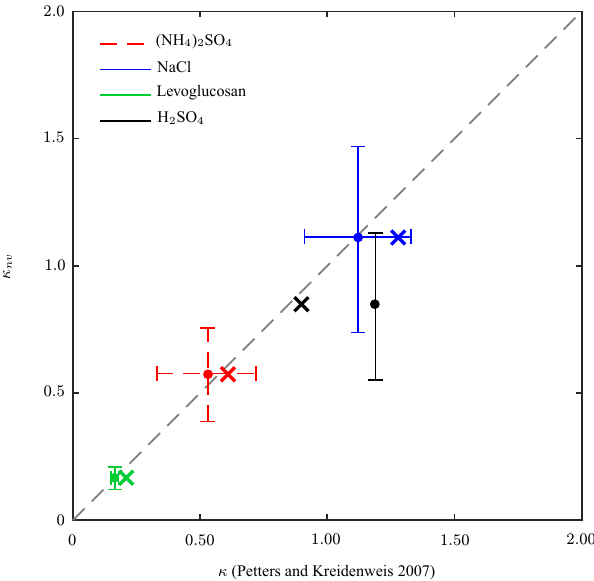
Figure 2. Growth-factor-derived hygroscopicity, κ , of non-volatile compounds from Petters and Kreidenweis (2007) plotted against the values from our Monte Carlo approach. Mean values from the CCN- derived and growth-factor-derived experimental methods are shown by the crosses and dots, respectively, with y coordinates showing the mean from our approach. Horizontal error bars show κ low and κ up from the growth-factor-derived κ given in Table 3, and the ver- tical error bars show the 16th and 84th quantiles of our derived values. Ammonium sulfate is shown in red with dashed error bars, sodium chloride is shown in blue, levoglucosan is shown in green and sulfuric acid is shown in